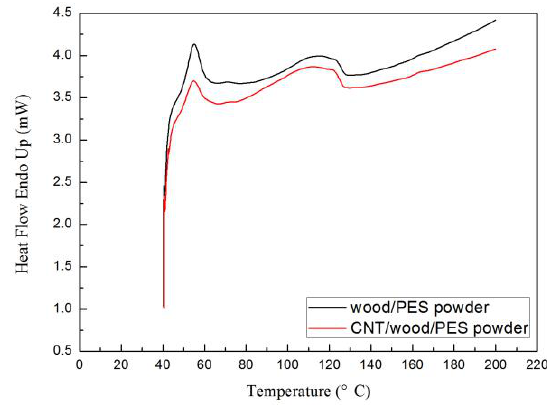
Figure 8. DSC curves of wood/PES powder and CNT/wood/PES powder.